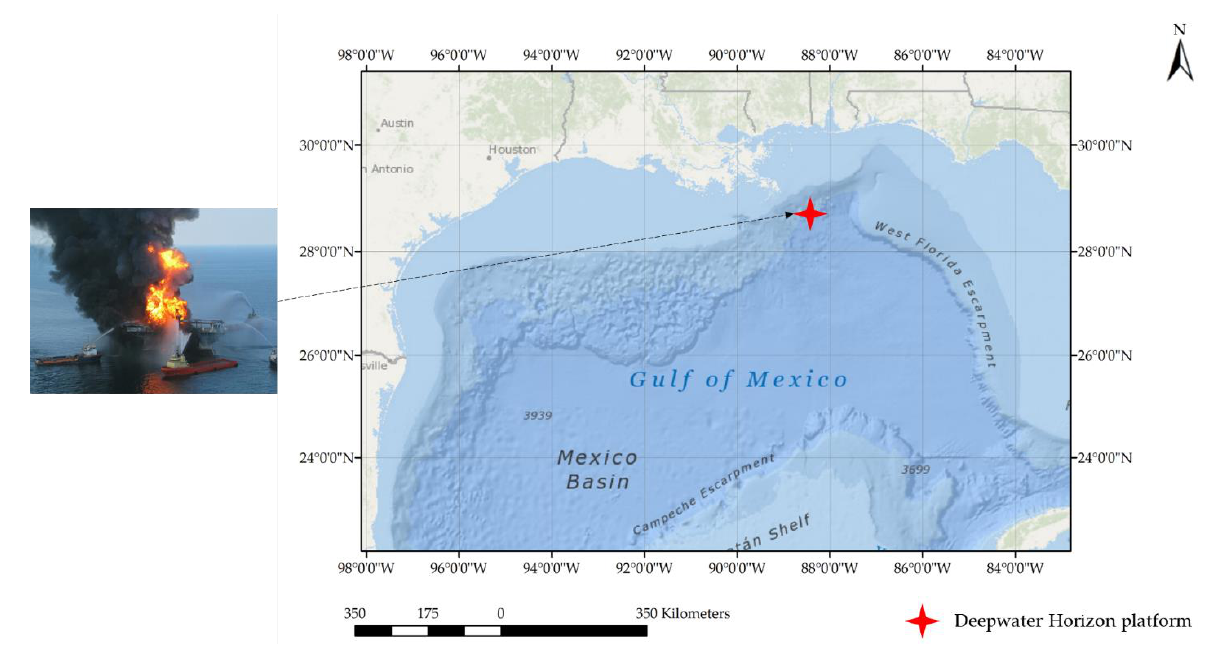
Figure 1. Location of DWH oil spill.